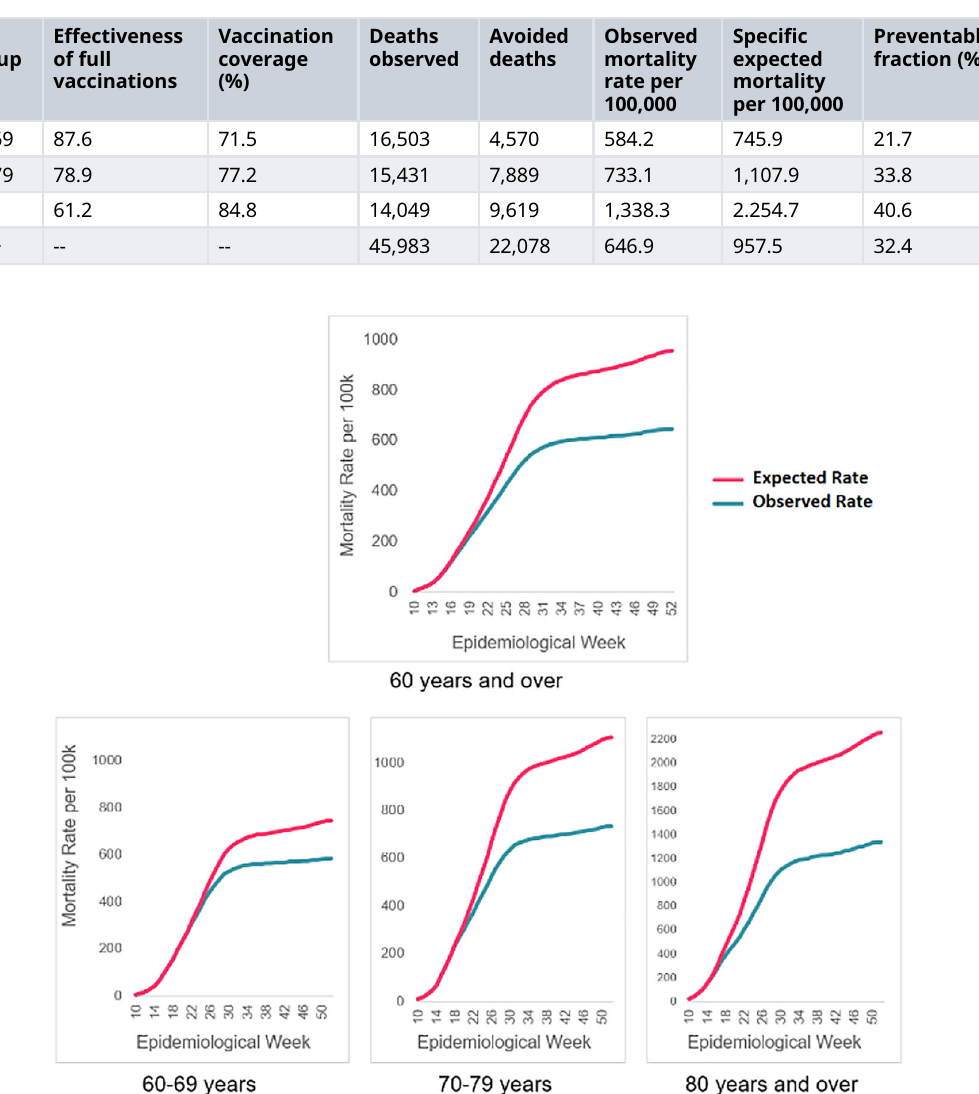
Figure2.AccumulatedCOVID-19mortalityratesexpectedvsobserved. Avoideddeathsforadults60yearsofage and older as of vaccination. Colombia,